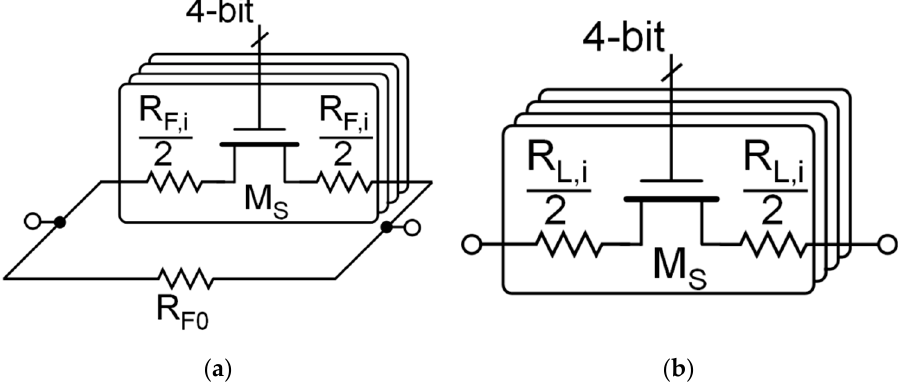
Figure 4. Implementation of the 4-bit programmable resistor arrays ( a ) feedback resistor, R F , and ( b ) load resistors, R L , i